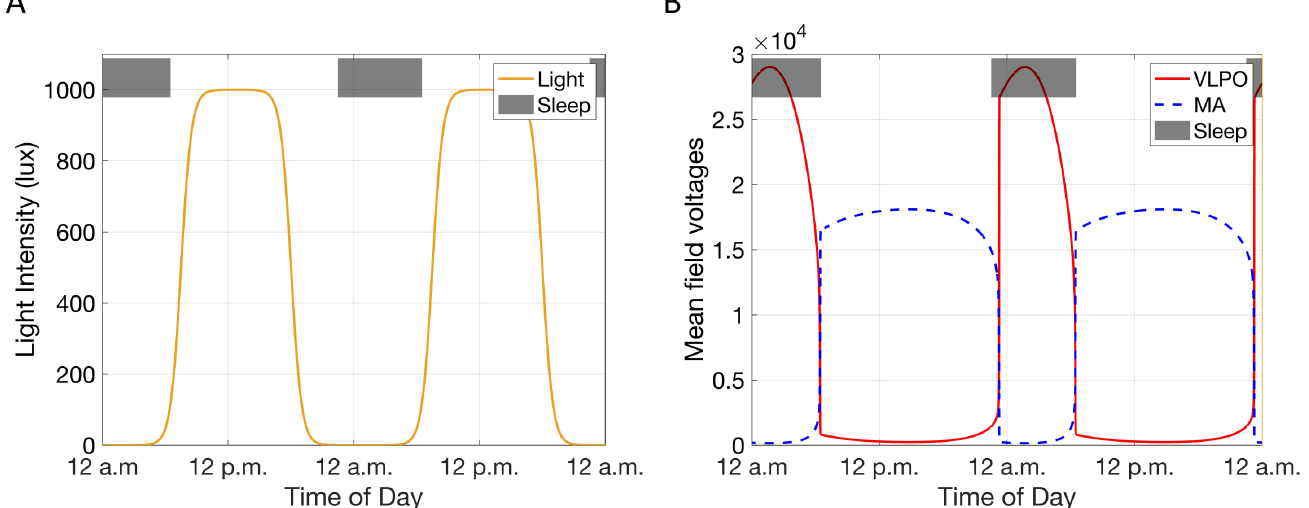
Figure 2. ( A ) Forty-eight hours of the nominal light schedule [maximal light intensity of 1000 lux after simulated sunrise (6 a.m.) and a minimal light intensity of 0 lux after simulated sunset (6 p.m.)] used for model simulations. ( B ) The mean-field firing rates of the wake-active, MA (blue), and sleep-active, VLPO (red) populations across 48 h. The model describes a simulated sleep-state (black shaded bars at top of panels) when the mean firing rate for the sleep-active population (VLPO) is greater than that of the wake-active neuronal population (MA) and describes a simulated wake-state (no shaded bars at top of panel) when the firing rate for the wake-active population is greater than that of the sleep-active